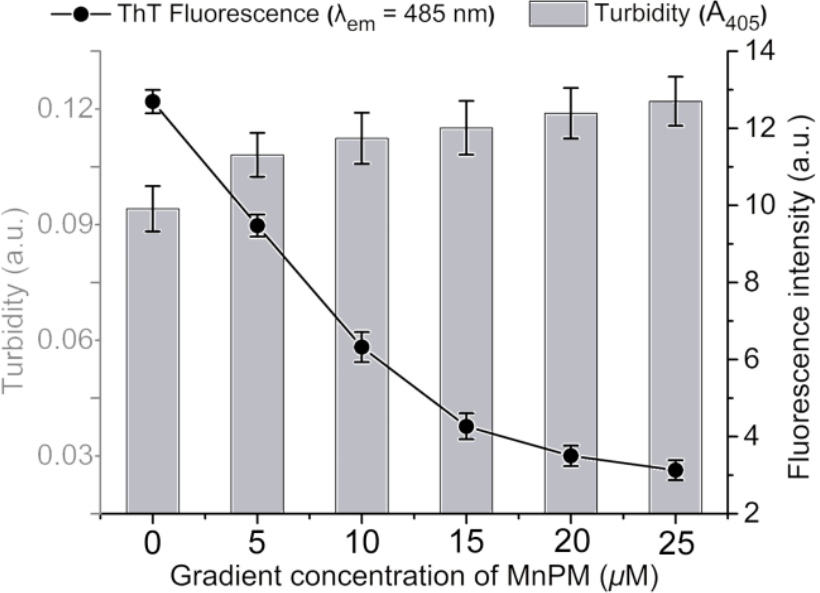
Figure 7. The effect of MnPM on the A β 40 (20 μ M) aggregates after being induced by Zn 2+ (40 μ M) for 24 h determined by ThT assay ( λ ex = 415 nm, λ em = 480 nm) and turbidimetry (All the samples with final DMSO content: volume ratio 0.5%).